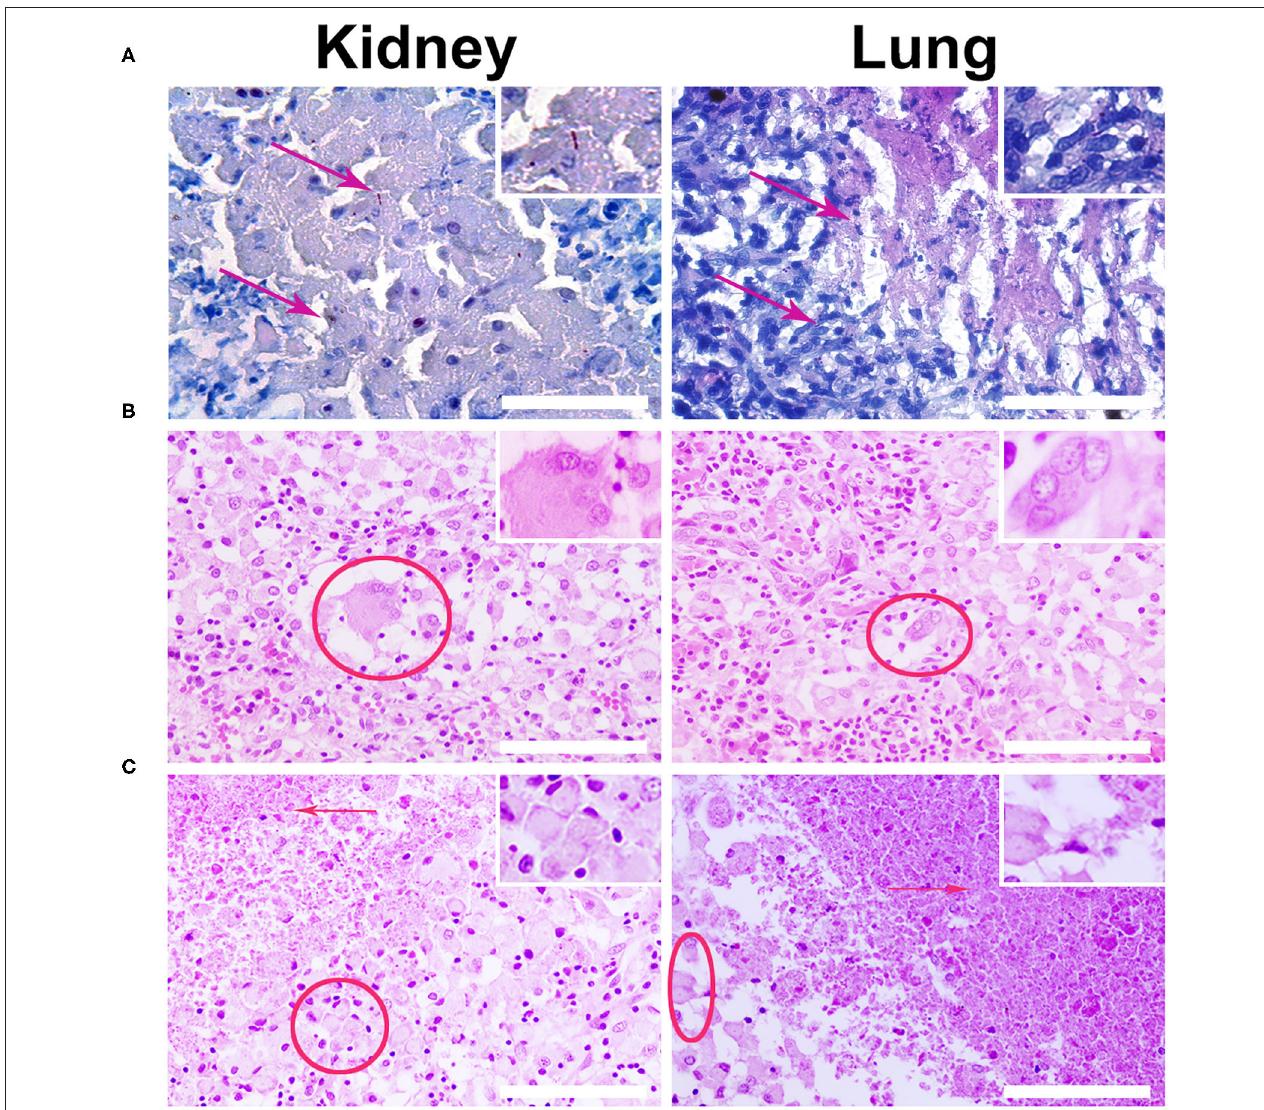
FIGURE 6 | Histological analysis of the kidney and lung tissue samples. (A) Representative images of the specific M. tuberculosis ( Mtb ) inflammation of the kidney and lung were stained according to Ziehl–Nielsen. Red arrows designate the acid-resistance bacteria ( Mtb ) in the kidney and lung. Scale bars, 300 µ m. (B) Biopsy histological assessment staining H&E of the kidney and lung wall inoculated with Mtb. Giant multinucleated cells of Langhans are indicated by red solid ellipse. (C) Red arrows point to caseous necrosis and epithelioid cells (red ellipse) as the specific histological markers of the tuberculosis inflammation. Staining by H&E. Scale bars, 200 µ